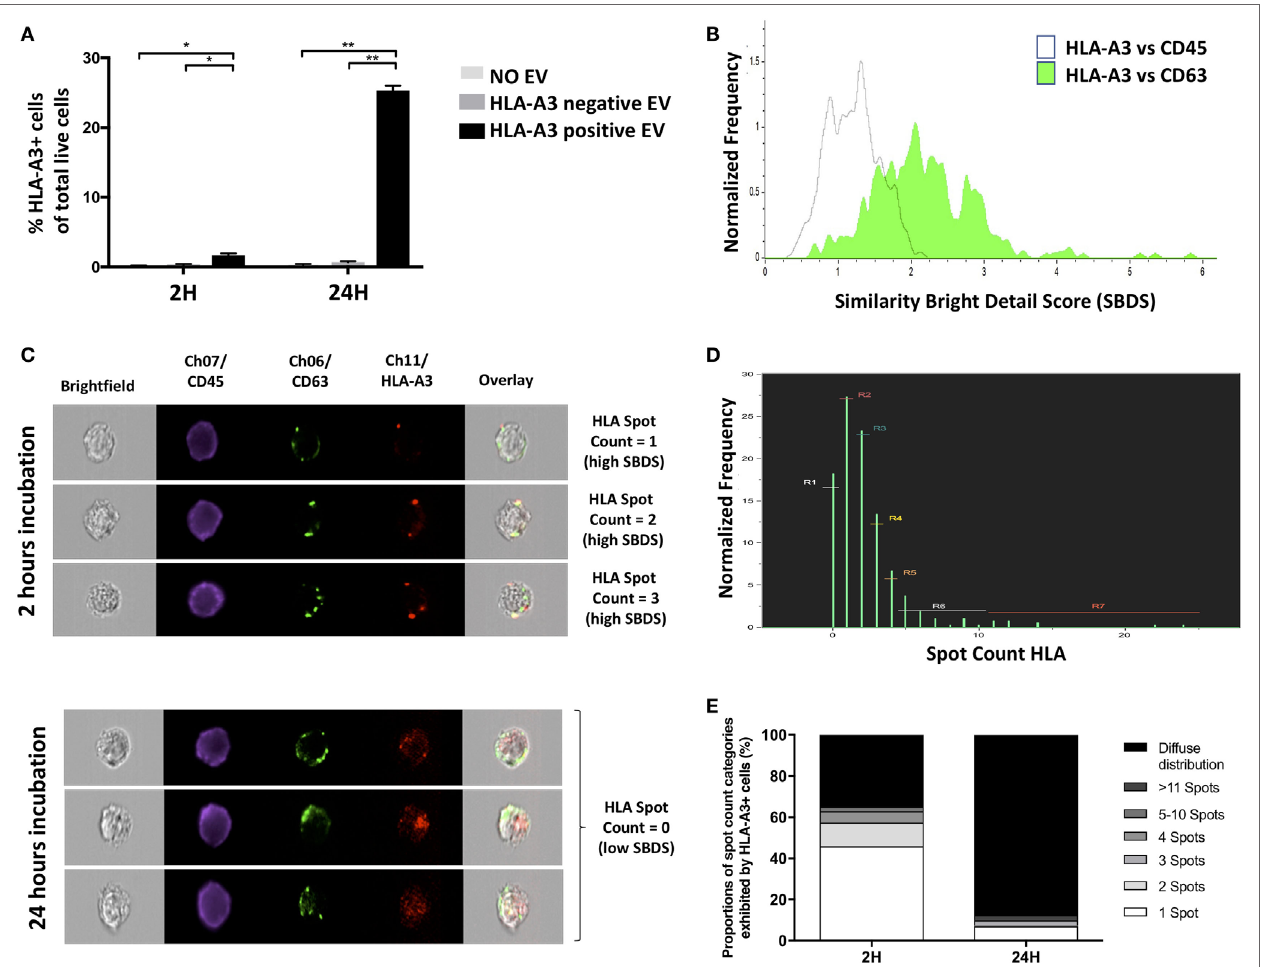
FIgURe 4 | Target-cell analysis determines exosome-mediated molecular transfer (Application 3). (A) Percentage of HLA-A3-positive cells detected by ISx following coculture of CD14 + cells from HLA-A3-negative individual with extracellular vesicles from HLA-A3 positive individual. Data represented as mean ± SD of two separate experiments. * P < 0.05 and ** P < 0.01. (B) Representative histogram showing higher colocalization of fluorescently labeled HLA-A3 with CD63 as compared to CD45, as ascertained by the IDEAS ® Similarity Bright Detail Score (SBDS). (C) Representative ISx images of single cells following 2 h coculture exhibiting discrete HLA-A3 spots and with high HLA-A3/CD63 SBDS scores (left panels), contrasted with images of cells following 24 h coculture exhibiting diffuse HLA-A3 fluorescence and with low HLA-A3/CD63 SBDS scores; suggesting incorporation and diffusion of exosome-derived HLA molecules over time. (d) Representative histogram showing the normalized frequencies of HLA-A3 positive cells exhibiting a given number of HLA-A3 “spots,” as ascertained by the IDEAS ® Spot Count feature, following 2 h EV coculture. (e) Summary of proportions of HLA-A3 positive cells exhibiting a given number of HLA-A3 spots, following either 2 or 24 h EV coculture. Data presented as the mean of two separate